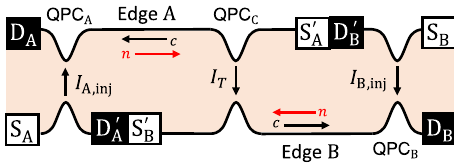
= †† Fig. 3 | Monodromy M for non-Abelian anyons. Two particle-hole pairs of ψ anyons are initially split from the vacuum ( I ). After the braiding, they fuse into the vacuum. The monodromy isthe amplitude of this process. The red and blue loops correspond to anyons that tunnel at QPC A/B and QPC C , respectively [See the loops of the same colors in Fig. 1c]. Untying the topological link between the loops amounts to the monodromy M (or M * depending on the direction of the loops).